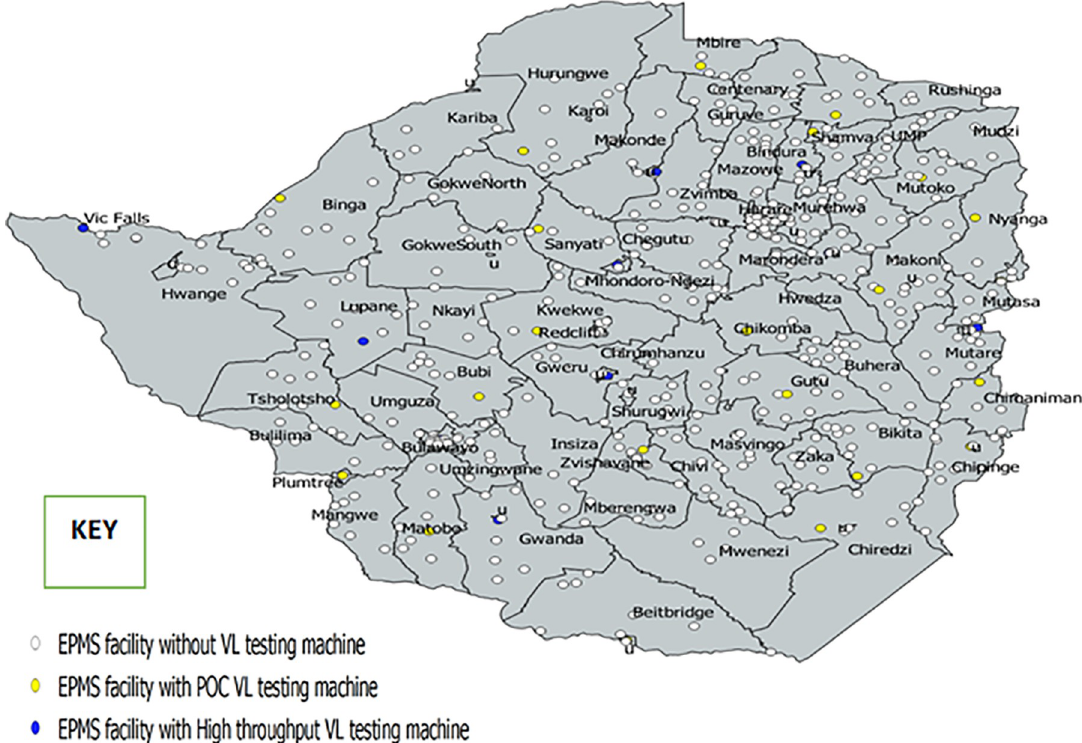
Fig 1. Distribution of health facilities using the ePMS versus those with highthroughput viral load testing machines and point-of- care testing machines. ePMS = electronic Patient Monitoring System; POC VL = point-of-care viral load.